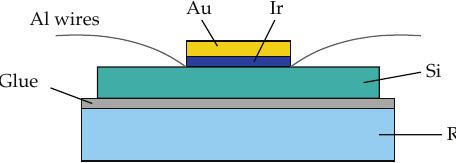
Figure 30: Schematic drawing of the Ir-Au/Re TES microcalorime- ter developed at